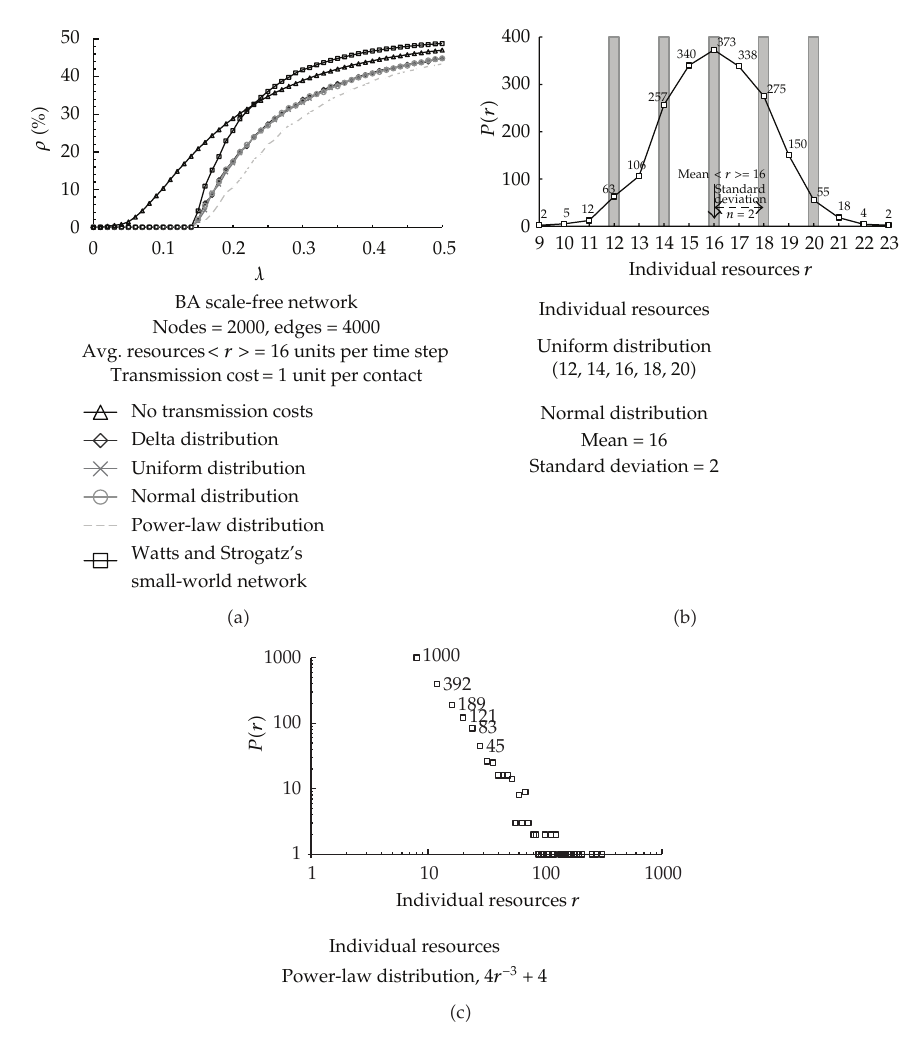
Figure 6: Simulation results for Scale-free network #3. (cid:3) a (cid:4) E ff ects of di ff erent statistical distribution types for agent resources on the density curves and epidemic tipping points of computer viruses spread within scale-free networks. (cid:3) b (cid:4) Uniform (cid:3) n (cid:7) 5, r (cid:7) 2 (cid:4) and normal (cid:3) standard deviation (cid:7) 2 (cid:4) distributions of agent resources with an average (cid:3) r (cid:4) value of 16. (cid:3) c (cid:4) Power-law distribution (cid:3) degree (cid:7) 3 (cid:4) of agent resources.